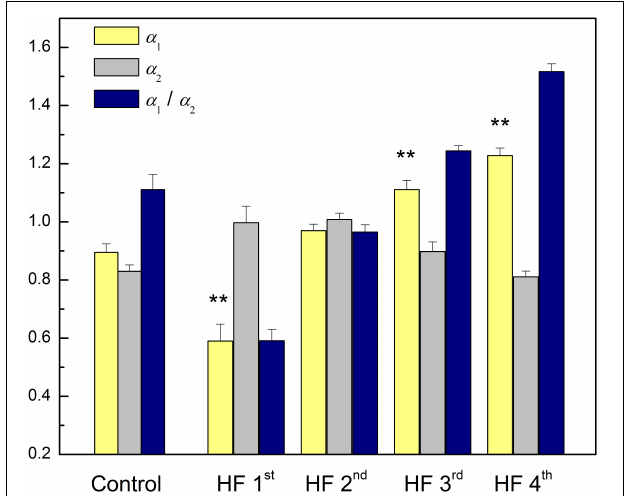
FIGURE 4 | The distribution of relative spectral components in clusters determined by the ratio of the scaling exponents. Values are given as mean plus standard errors. Relative VLF spectral component (rVLF) was significantly different between control group and two clusters (2nd and 3rd), p < 0.01. Relative LF spectral component (rLF) was significantly different between control group and three clusters (1st, 2nd, and 3rd), p < 0.01. Relative HF spectral component (rHF) was significantly different between control group and two clusters (1st and 3rd), p < 0.05, and with tendency toward statistical significance with the 4th cluster ( p = 0.08). Significant and toward significant differences of comparison between clusters of heart failure patients are for rVLF (1st vs. 2nd, p = 0.07 and 1st vs. 3rd, p = 0.08), for rLF (1st vs. 4th, p < 0.01, and 2nd vs. 4th, p = 0.01), and for rHF (1st vs. 2nd, 1st vs. 3rd, and 1st vs. 4th, p <